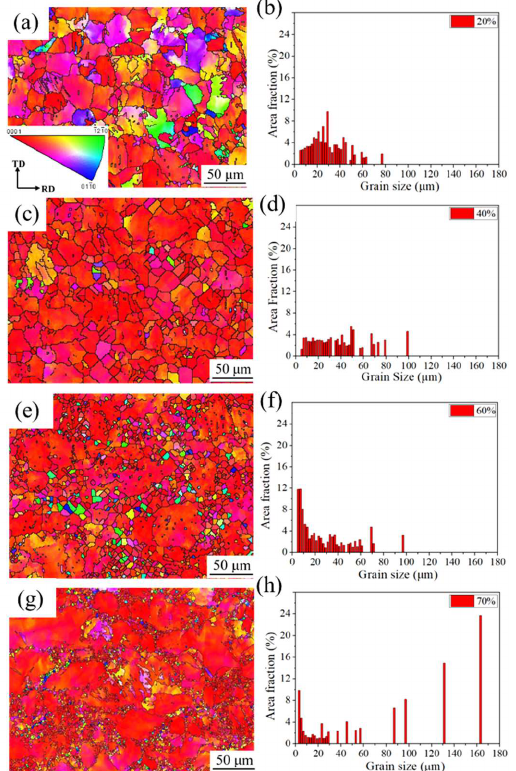
Figure 3. The ( a , c , e , g ) EBSD grain maps and ( b , d , f , h ) grain-size statistics of the HER alloys; ( a , b ) 20%-HER alloy, ( c , d ) 40%-HER alloy, ( e , f ) 60%-HER alloy, and ( g , h ) 70%-HER alloy [30].